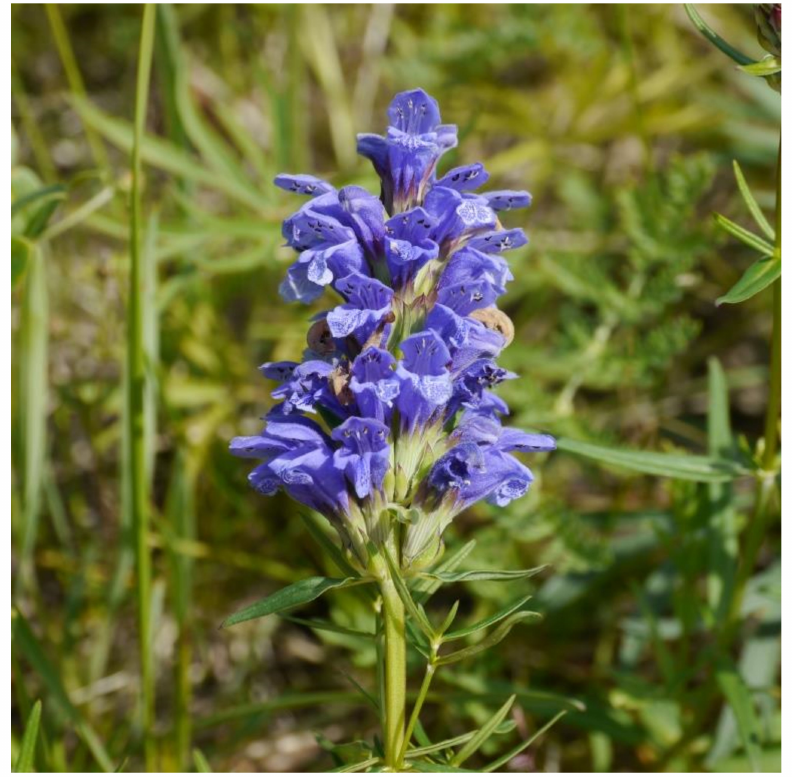
Figure 2. Dracocephalum ruyschiana L. in the Amga area of Yakutia (photo taken by Okhlopkova, July